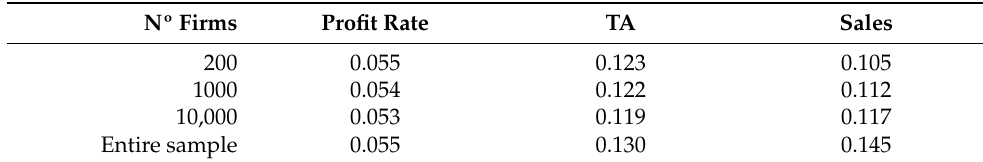
Table 3. Median of the estimates of the scale parameter reported in Figure